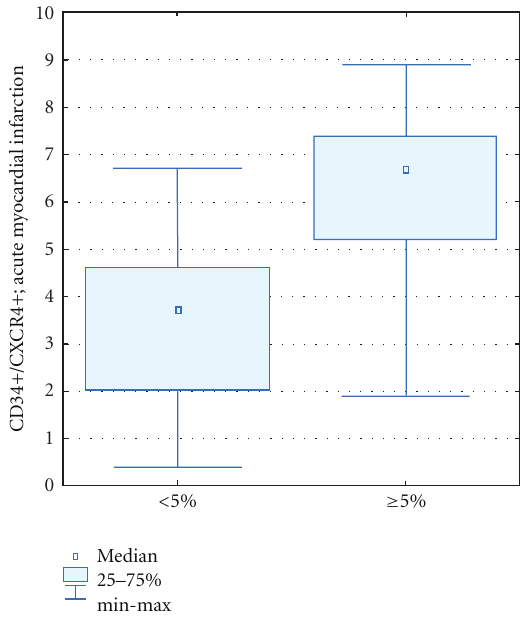
Figure 8: Comparison of CD34+/CXCR4+ progenitor cells mobi- lization in the acute phase of myocardial infarction in patients with the absolute LVEF improvement ≥ 5% ( Δ ≥ 5%); 12-month clinical